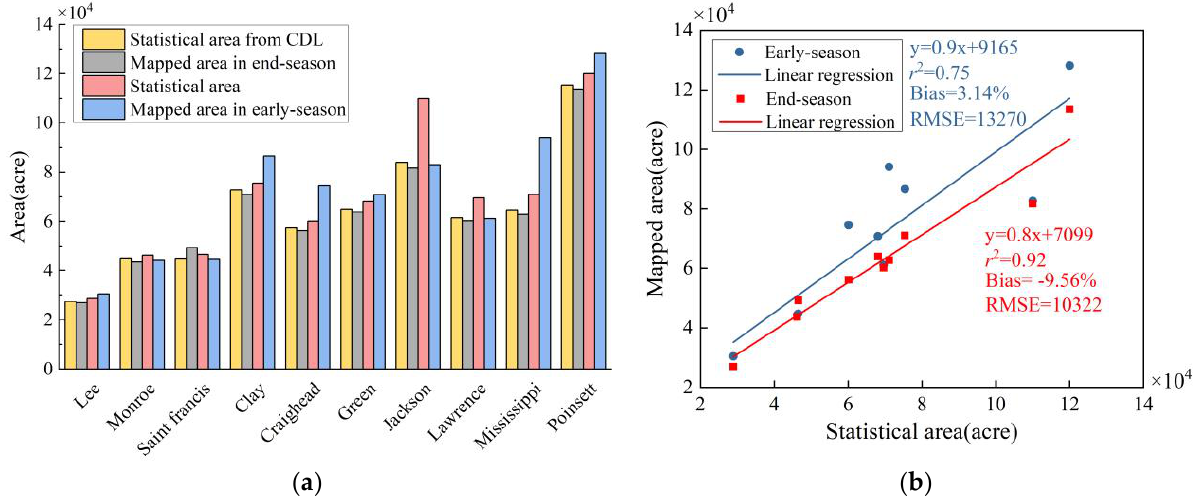
Figure 15. A comparison of paddy rice area estimates by 10 counties between the rice paddy map in 2020 and the statistical data reported in 2020. This comparison used the linear regression model of y = a × x + b. The end-season map was made on 17 September. The early-season map was made on 23 July. ( a ) Area statistics histogram. ( b ) A comparison of paddy rice area estimates between mapping and statistics.